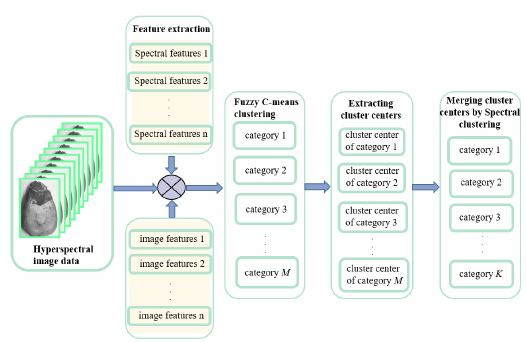
Figure 2. Diagram of the co-clustering algorithm.